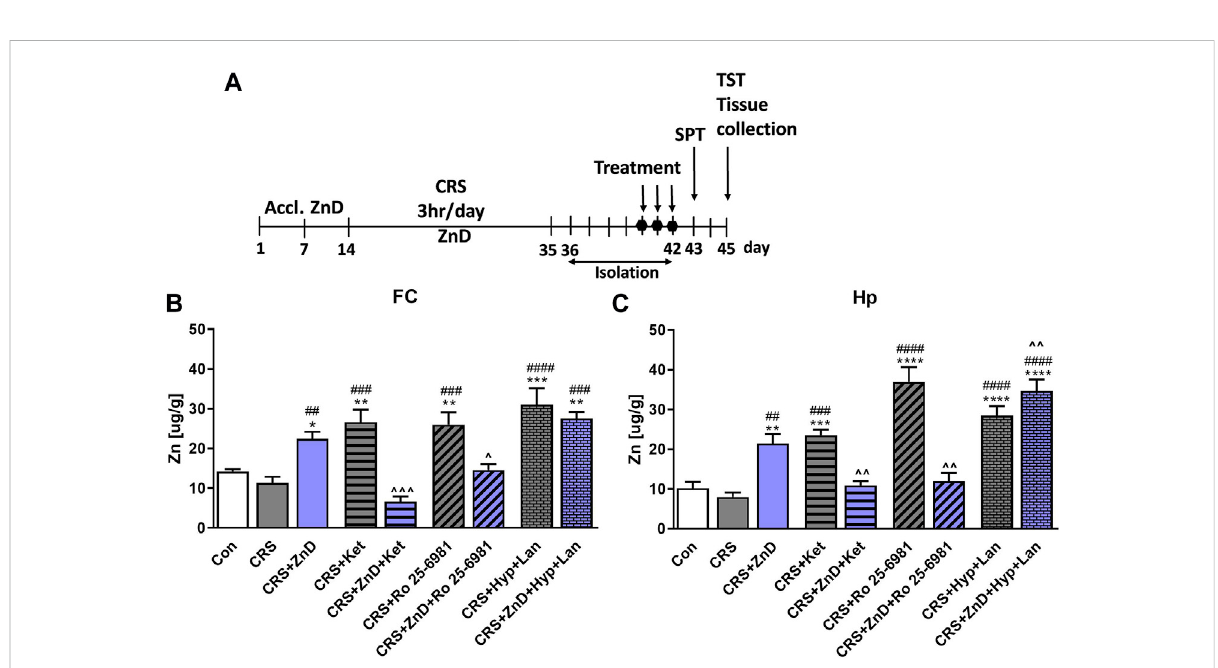
FIGURE 6 Effectsofthreedosesofatypicalantidepressantcompounds(ketamine:10 mg/kg,Ro25 – 6981:10 mg/kg;Hyp:2.5 mg/kg+Lan:10 mg/kg)on ZnlevelsintheFCandHpofmicesubjectedtoCRSandCRS+ZnD. (A) Experimentalscheduleofdrugtreatmentsandbehavioraltests. (B) Znlevelin theFC and (C) Zn level intheHp. All valuesare expressed as mean ± SEM,n= 5 – 6. The data wereanalyzed by one-way ANOVA andNewman – Keuls multiple comparison test. FC: [F(8.45) = 13,15; p < 0.0001]; Hp: [F(8.42) = 23.56; p < 0.0001] * p < 0.05, ** p < 0.01, *** p < 0.001, **** p < 0.0001 vs. Con; ## p < 0.01, ### p < 0.001, #### p < 0.0001 vs. CRS, ^ p < 0.05, ^^ p < 0.01, ^^^ p < 0.001 vs. CRS + ZnD. Con: control, CRS: chronic restraint stress, Hyp: hyperforin, Ket: ketamine, Lan: